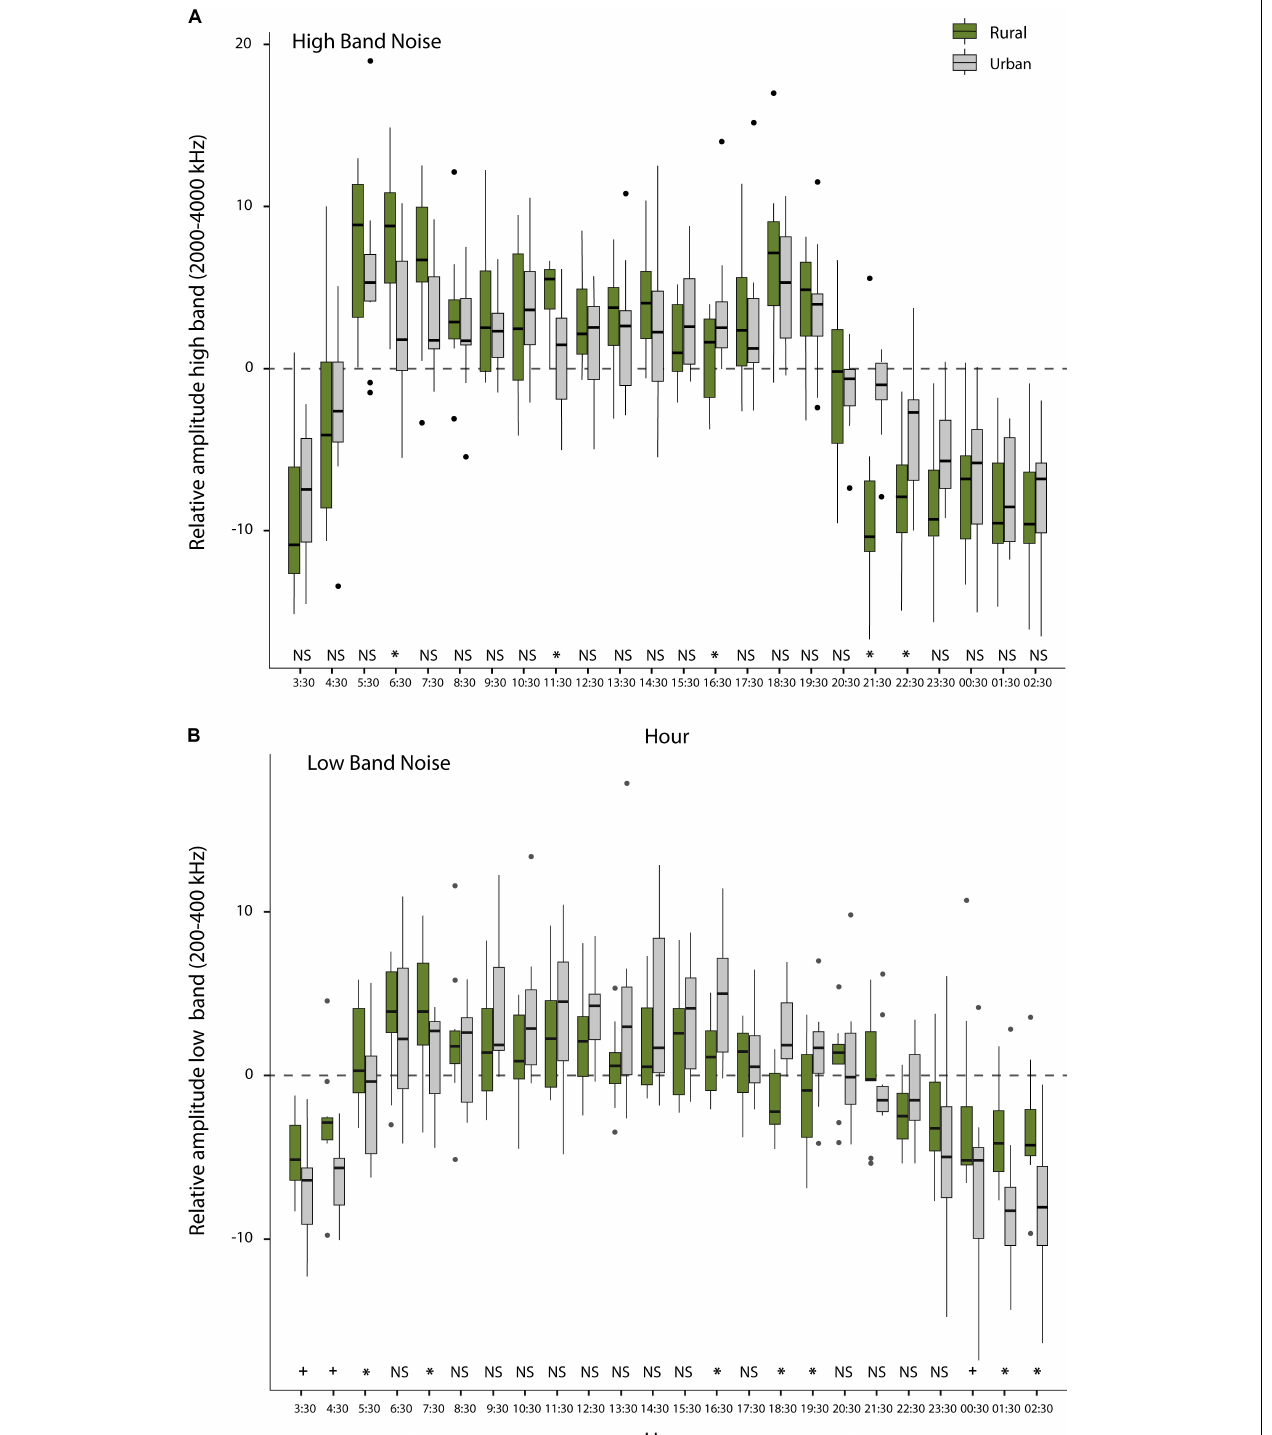
FIGURE 5 | Relative noise level fluctuations over the day: (A) Average noise level per hour subtracted from the overall mean of the day (represented with the zero value) for each habitat for the high-frequency band (2000–4000 Hz), reflecting fluctuations in local bird song activity other than that of the focal great tits; (B) Average noise level per hour subtracted from the overall mean of the day (represented with the zero value) for each habitat for the low-frequency band (200–400 Hz), reflecting local fluctuations caused by traffic noise (* indicates a significant difference at p < 0.05 level and + means a non-significant trend). See text for statistics. The dashed line illustrates the overall noise of the